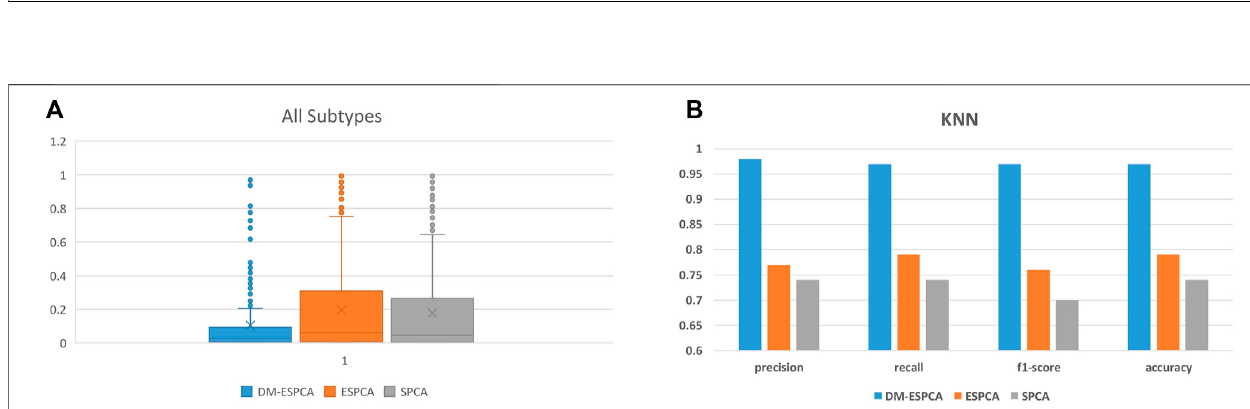
FIGURE 6 | Functional pathways collected from the BCI data set Luminal A subtype; (A) results of GO-BP in the DMESPCA model; (B) results of GO-BP in the ESPCA model; and (C) results of GO-BP in the SPCA model.